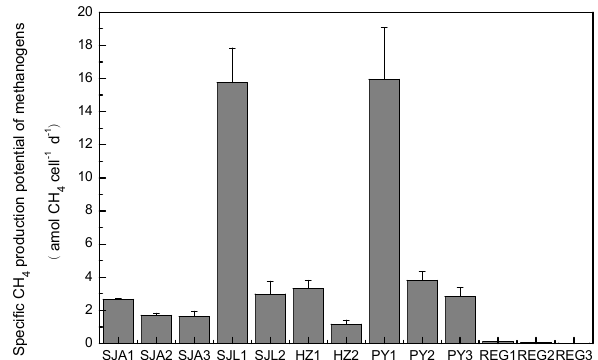
Fig. 7. Specific CH 4 production potential of methanogens (CH 4 production potential per cell) in different soil layers of the San- jiang Plain C. angustifolia (SJA1 = 0–20cm, SJA2 = 20–40cm, SJA3 = 40–60cm) and C. lasiocarpa (SJL1 = 0–30cm, SJL2 = 30– 60cm) marshes, Hongze wetland (HZ1 = 0–20cm, HZ2 = 20– 40cm), Poyang wetland (PY1 = 0–10cm, PY2 = 10–20cm, PY3 = 20–40cm) and Ruoergai peatland (REG1 = 0–10cm, REG2 = 10–20cm, REG3 =